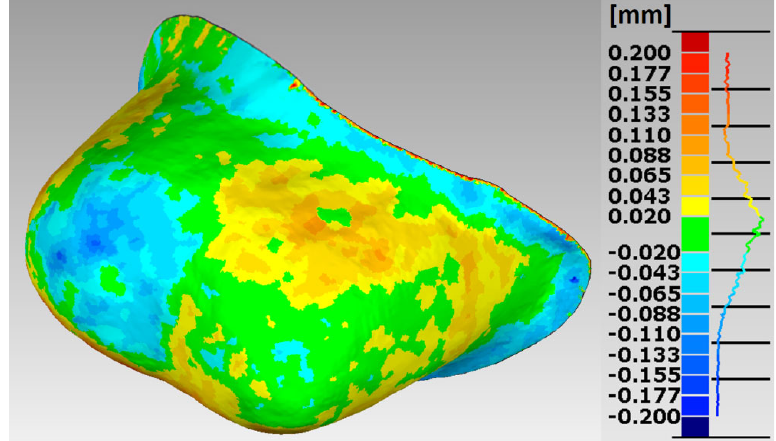
Figure 7. Map of errors in mapping the shape of a crown made of Ti6Al4V alloy in SLM for premolar 15.